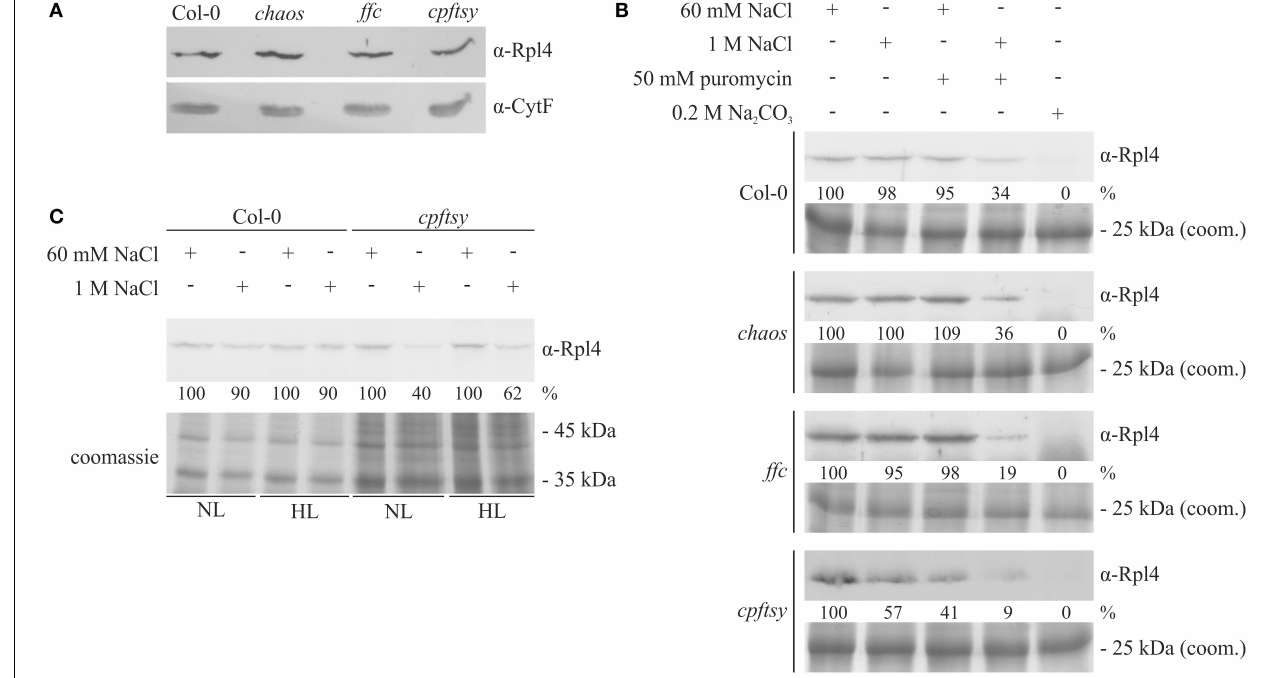
membranes and the large ribosomal subunit protein Rpl4 was detected using a specific antibody. The signals were quantified using the ImageJ program. To control the equal loading, thylakoid membrane proteins corresponding to 7.5 µ g chlorophyll were separated by SDS-PAGE and visualized by coomassie staining. (C) Wild type and cpftsy plants were exposed for 8h to normal light (120 µ mol photons m − 2 s − 1 ) and high light conditions (1000 µ mol photons m − 2 s − 1 ). Subsequently, thylakoid membranes were isolated and washed with lysis buffer supplemented with 60mM NaCl or 1M NaCl. Thylakoid membrane proteins corresponding to 15 µ g chlorophyll were separated by 12% SDS-PAGE, transferred onto nitrocellulose and the ribosomal Rpl4 protein was detected using a specific antibody. The signals were quantified using the ImageJ program. To control the equal loading, thylakoid membrane proteins corresponding to 7.5 µ g chlorophyll were separated by SDS-PAGE and visualized by coomassie